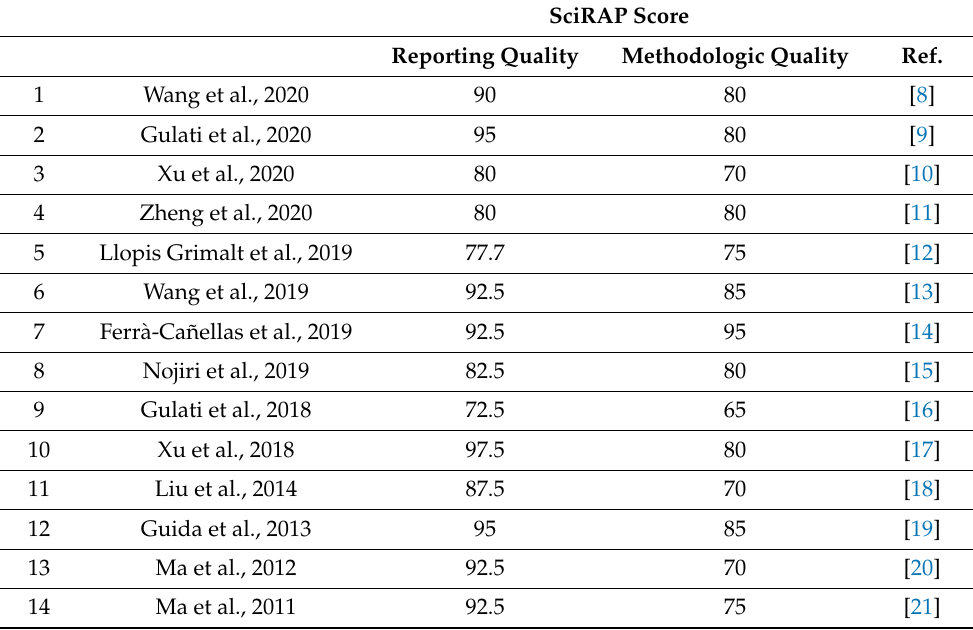
Table 2. Reporting and methodological quality score of the studies included calculated with the SciRAP